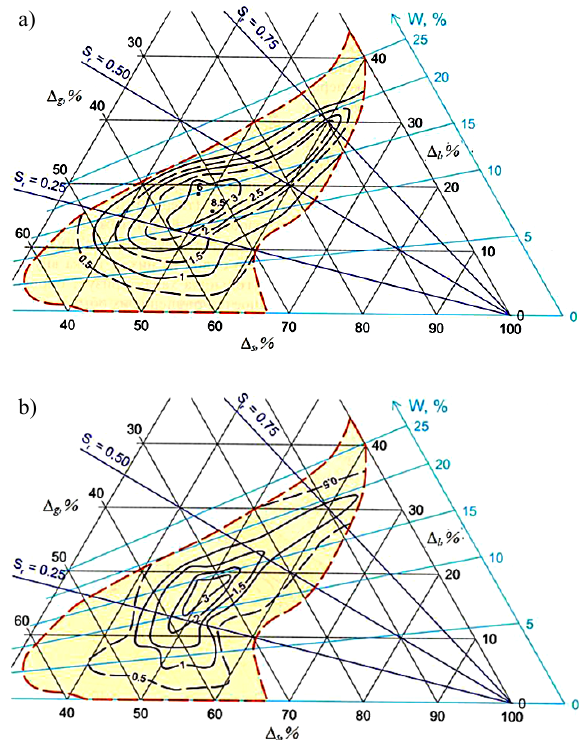
Fig. 5. The diagram of maximal moisture stream values of q wT – 10 –2 , g/cm 2 through 4 (а) and 20 (b) hours from the experience beginning depending on sand phase composition